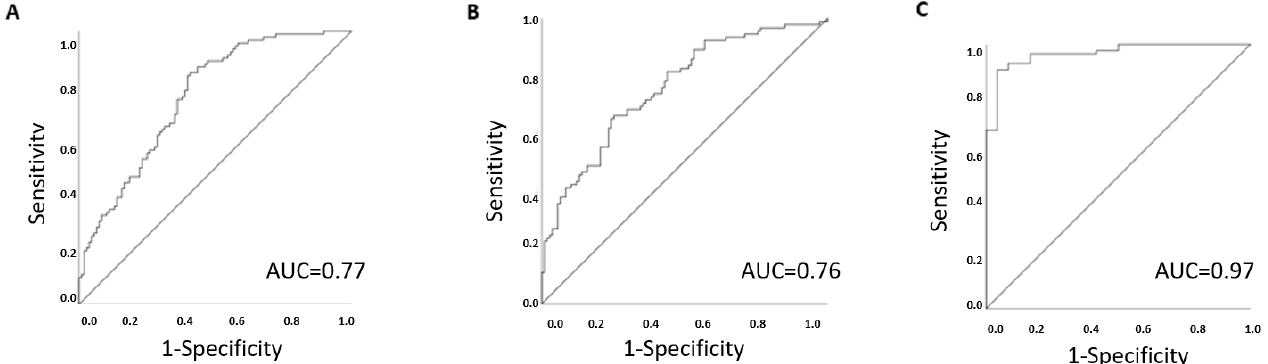
Figure 1. Individual metabolite odds ratios (95% CI) for ( A ) three classical traits (glucose, creatinine and albumin), ( B ) five CHD metabolites in the discovery cohort (1-arachidoniolyl 1-arachidonoyl-glycerylphosphorylcholine (GPC), asparagine, mannose, linolenate and dimethylglycine) and ( C ) four CHD metabolites in replication cohort (asparagine, mannose, lin- olenate and dimethylglycine).